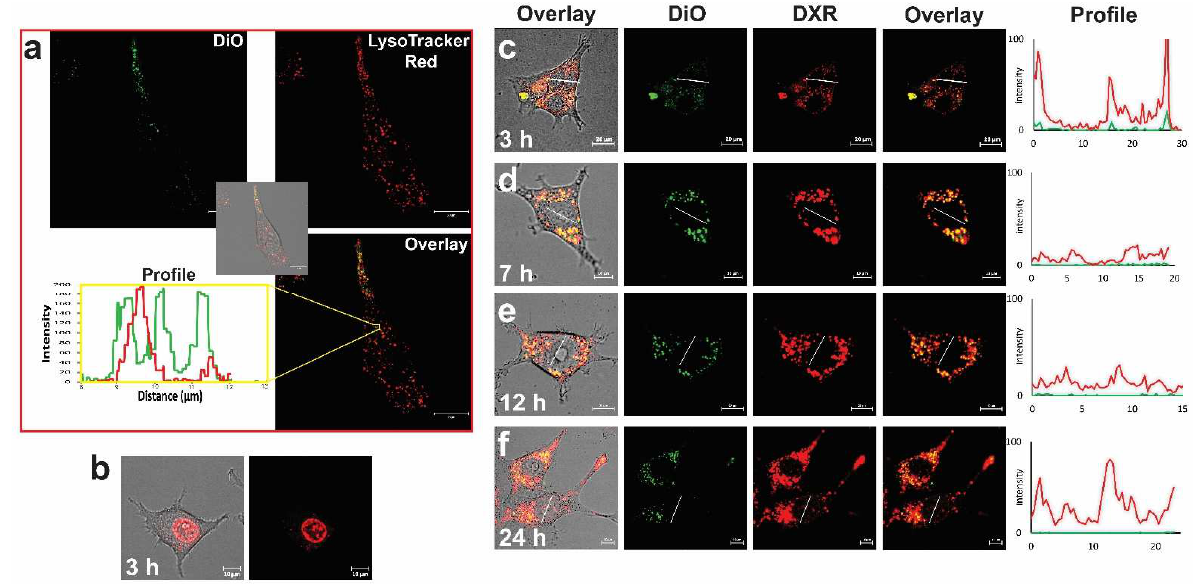
Figure 9. In vitro behavior of TAT-modified liposomes. Panel ( a ) illustrates internalization of Dio- labled TAT-modified liposomes by C26 cells via receptor-mediated endocytosis. Cells were pre-in- cubated with LysoTracker ® Red, and the profile view of DiO (green line) and LysoTracker ® Red (red line) along a line passed through red and green spots inside the cell after 3 h of incubation at 37 °C is depicted. Panels ( b – f ) represent the intracellular fate of DXR delivered to C26 cells at 37 °C as free DXR ( b ) or encapsulated in TAT-modified DiO-labled liposomes ( c – f ) at different times, after 3 h of exposure to preparations and washing. Profile views represent the intensity of DiO (green line) and DXR (red line) along a line passed through the cell. Reprinted and modified from [33] under the Creative Commons license.